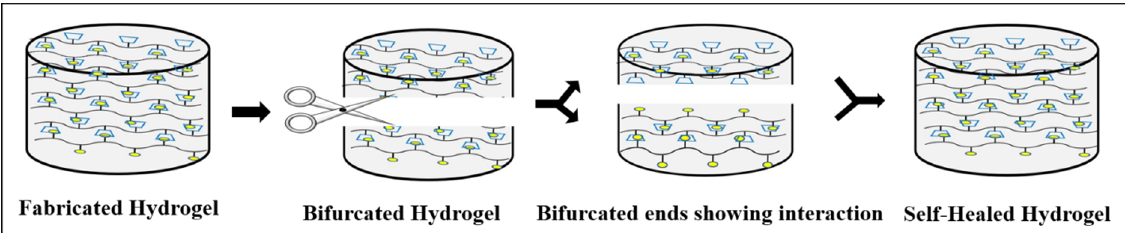
Figure 1. Demonstration of the healing process in a hydrogel.